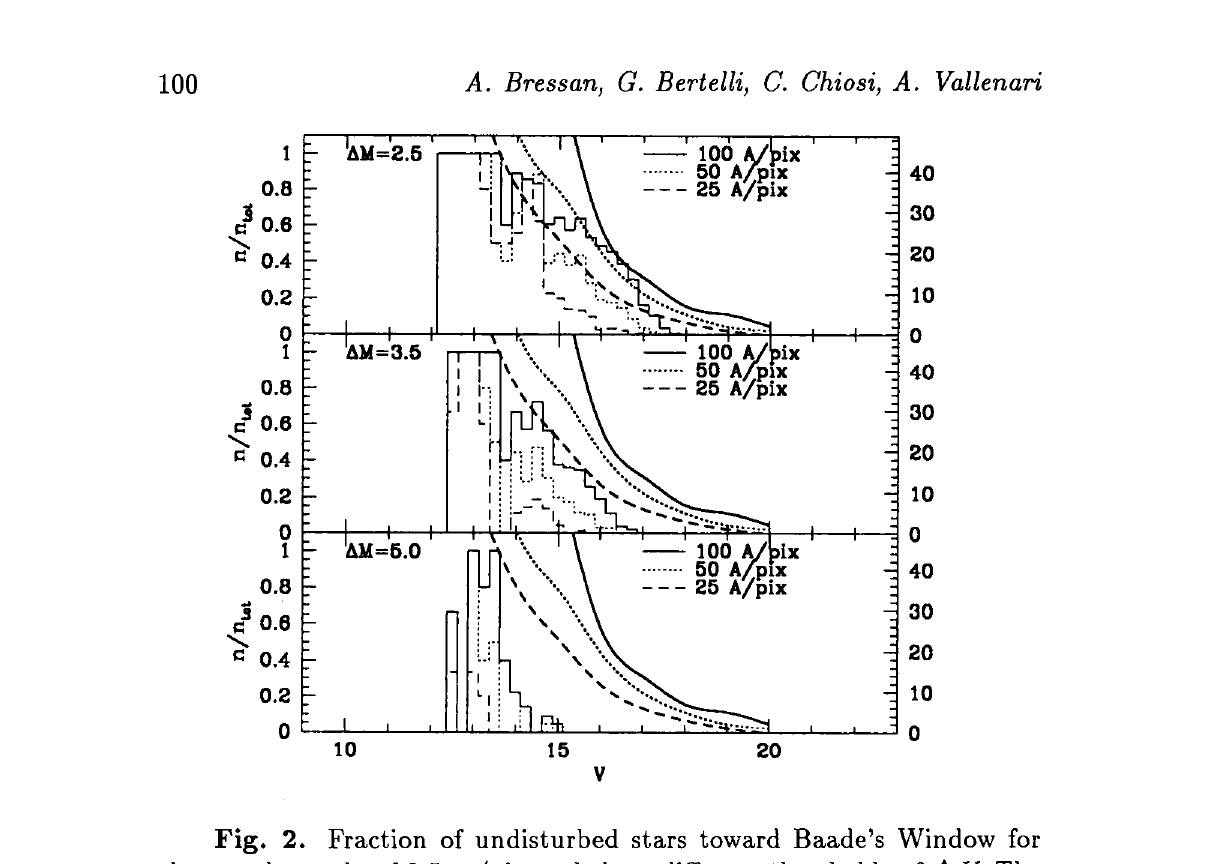
Fig. 2. Fraction of undisturbed stars toward Baade's Window for the angular scale of 0.5 as/pix and three different thresholds of Δ Κ The histograms depict the fraction of undisturbed objects as a function of the apparent V magnitude. In each panel, three different resolutions are considered. The curves indicate the signal to noise ratios (right scale) by Favata (1998) for the corresponding spectral